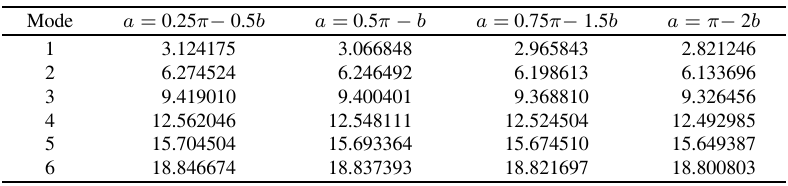
Table 2 Non-dimensional natural frequencies ofclamped-clamped rodswith A ( x ) = A 0 sin 3 ( ax + b ) for various values of a ( L 1 = 0, L 2 = 1, b = 1)